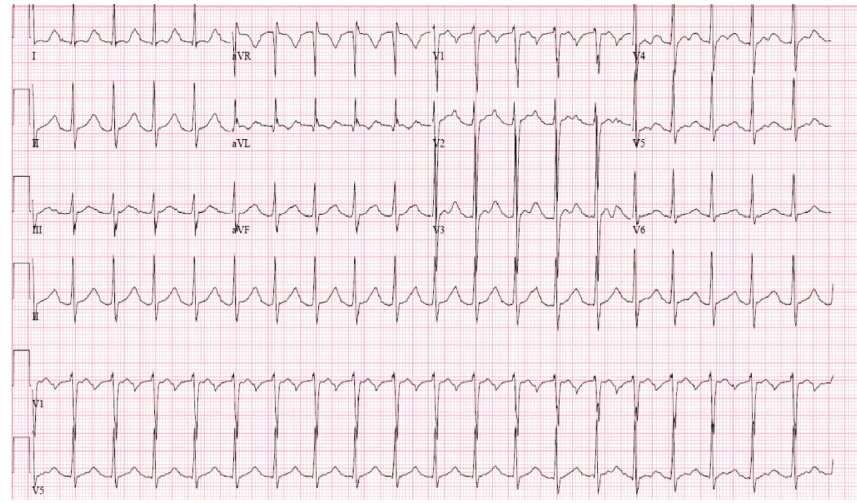
Figure 1: EKG on admission. Table 1: Pertinent laboratory values on admission.